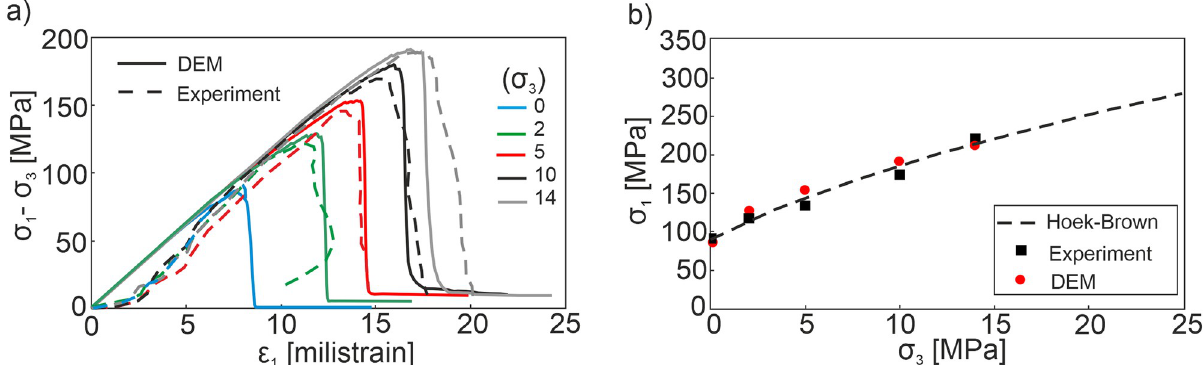
Fig 3. Triaxial compression test results under different confining stresses σ and laboratory experiments. (a) Stress-strain curves (b) Hoek-Brown failure envelope.